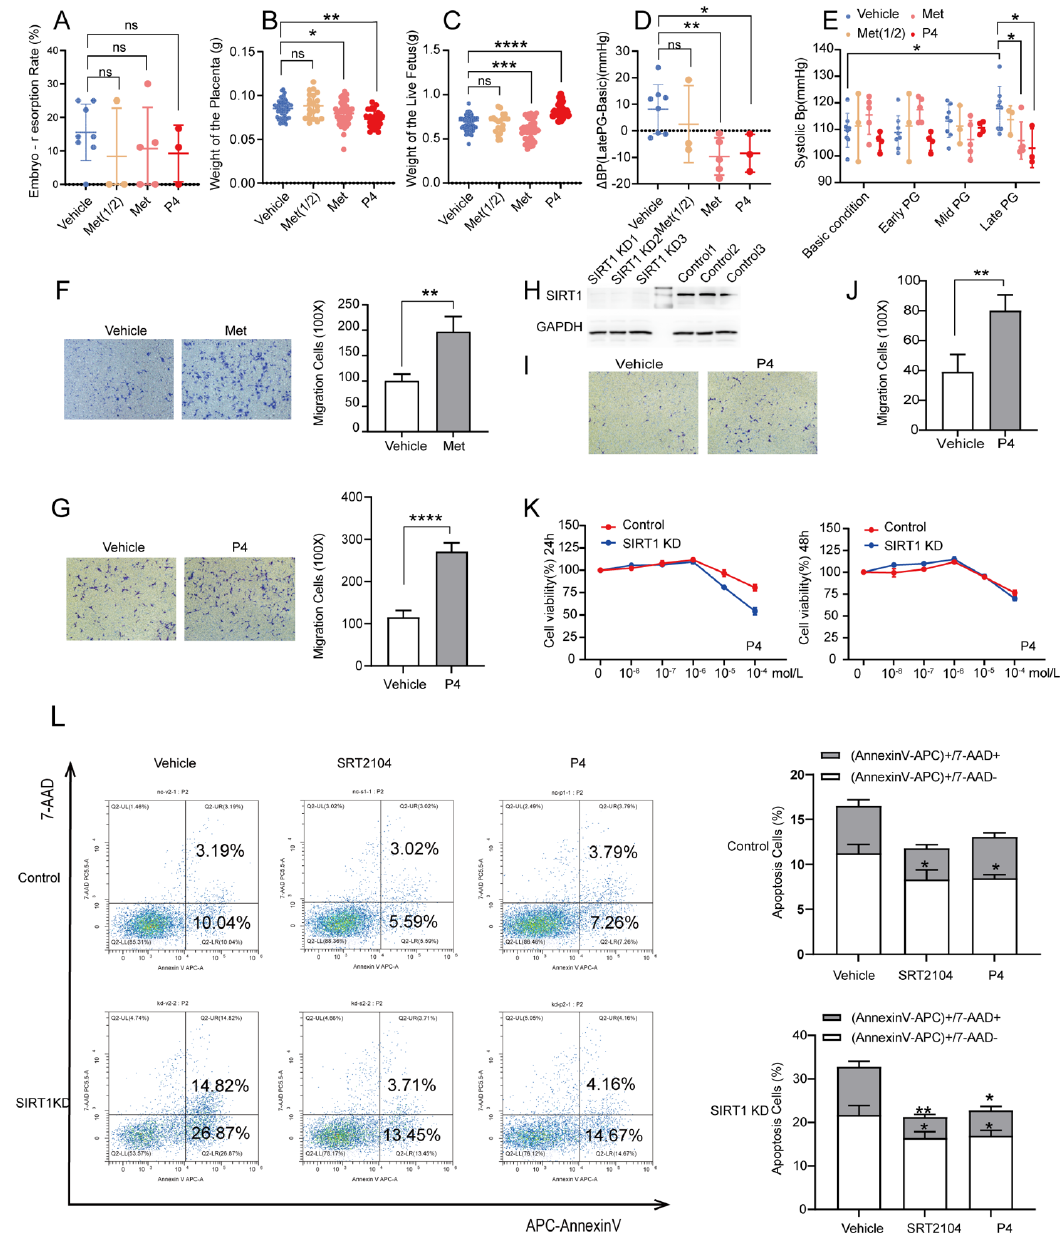
Figure 4. P4 could alleviate hypertension in SIRT1 +/ − mice and promote the invasion and inhibit the apoptosis of trophoblasts. ( A – E ) The embryo-resorption rate ( A ), the weight of the placenta ( B ), and the weight of the live fetus ( C ) in vehicle ( n = 8), Met (1/2) ( n = 3), Met ( n = 5), and P4 ( n = 3) groups. ( D ) ∆ BP (late PG—basic condition) in vehicle ( n = 8), Met (1/2) ( n = 3), Met ( n = 5), and P4 ( n = 3) groups. ( E ) The SBP at basic condition, early PG, mid PG, late PG from vehicle ( n = 8), Met (1/2) ( n = 3), Met ( n = 5), and P4 ( n = 3) groups. ( F , G ) The invasion ability of Transwell assay in vehicle, Met ( F ), and P4 ( G ) groups of control group. ( H ) Western blot analysis of SIRT1 protein levels in trophoblasts of SIRT1 KD and control groups. ( I ) The invasion ability of Transwell assay of vehicle and P4 groups in SIRT1 KD trophoblasts. ( J ) Statistics of migrating cells. ( K ) The proliferation function checked by CCK8 at 24 h and 48 h treated with P4 (concentration: 0, 10 − 8 , 10 − 7 , 10 − 6 , 10 − 5 , 10 − 4 mol/L) in SIRT1 KD trophoblasts. ( L ) The apoptosis assay of vehicle, SRT2104 and P4 groups in SIRT1 KD trophoblasts. Error bars, mean ± SD. The data were analyzed by one-way ANOVA (and nonparametric or mixed) and unpaired Student’s test (and nonparametric tests). * p < 0.05; ** p < 0.01; *** p < 0.001; **** p < 0.0001, ns: no